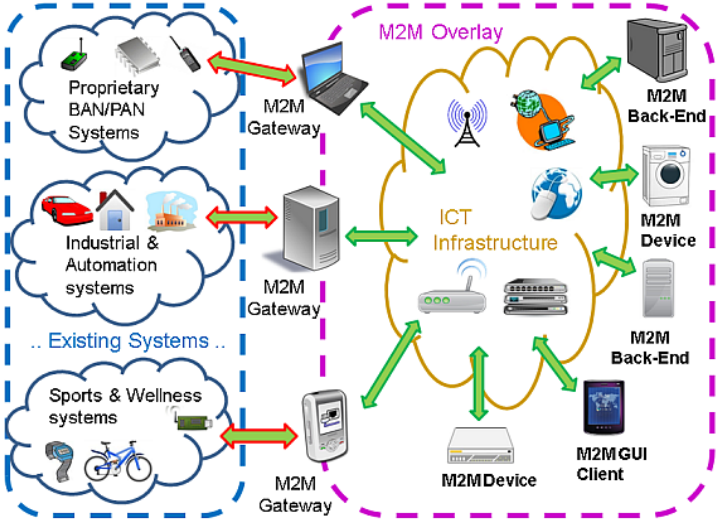
Figure 2. The M2M Gateway as an enabler of